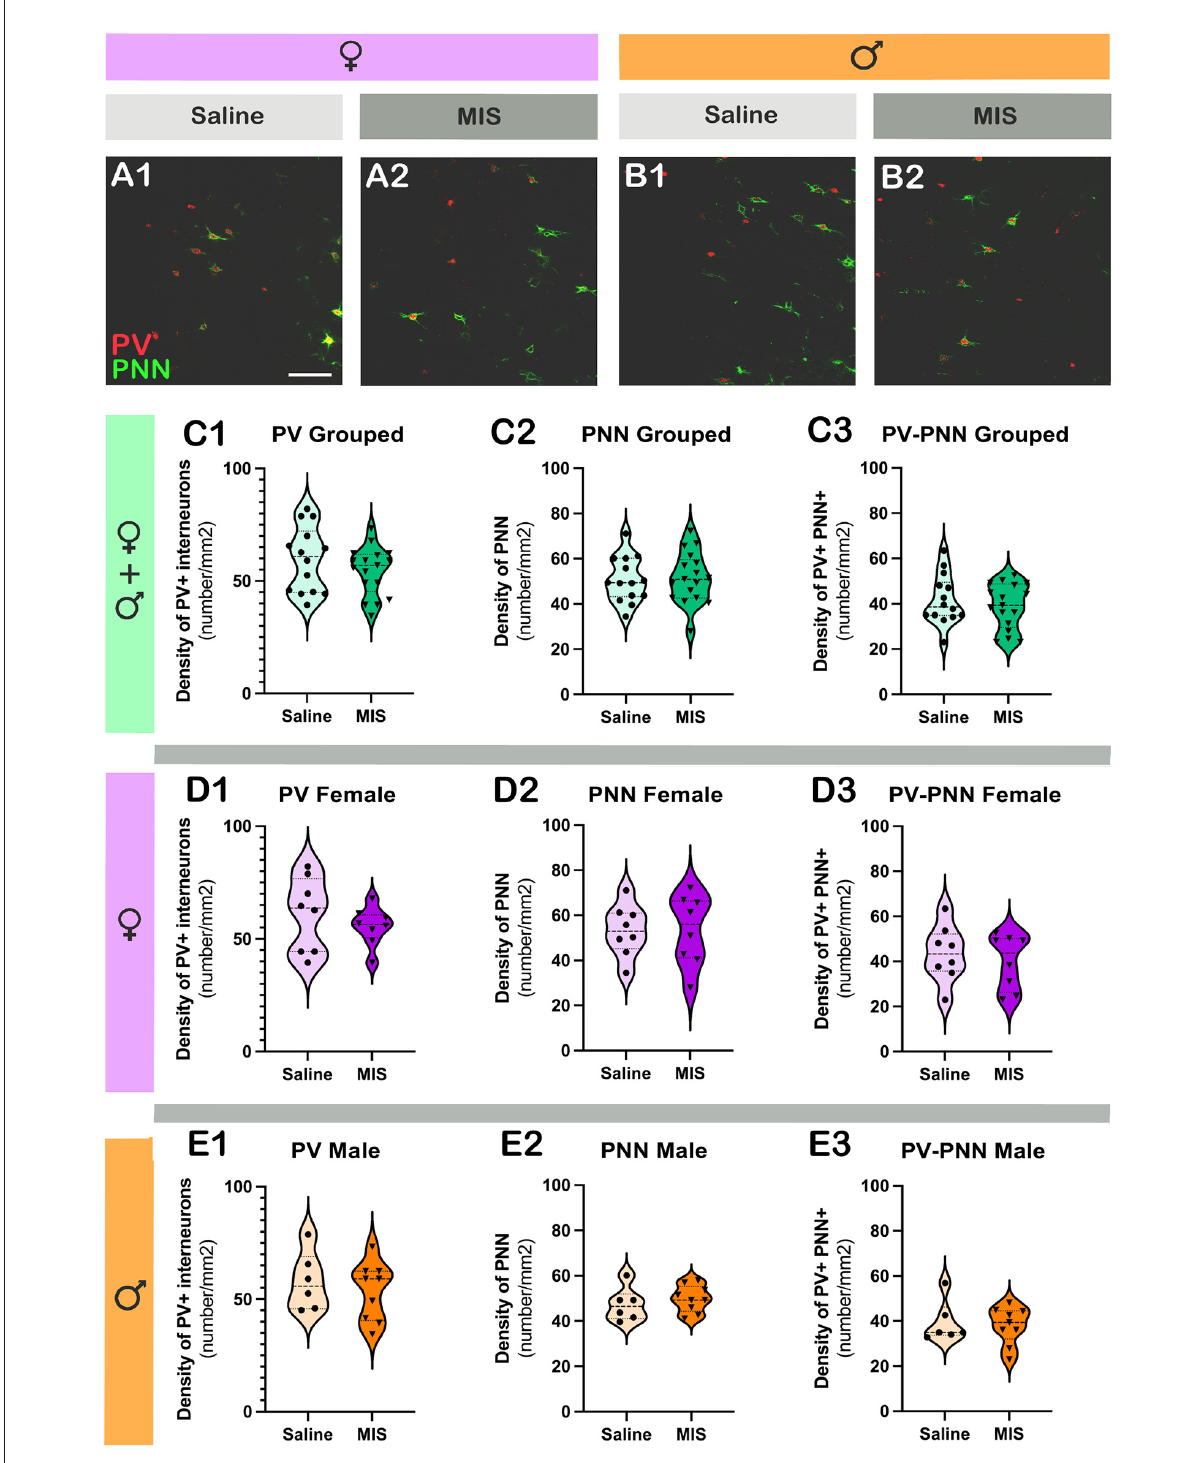
FIGURE4 Analysis of the density of parvalbumin+ interneurons (PV) and perineuronal nets (PNN) in the prelimbic cortex, subregion of the mPFC. (A,B) Representative single confocal planes of parvalbumin+ interneurons (red, PV) and perineuronal nets (green, PNN) of control and MIS treated rats in females (A) and males (B) . (C–E) Graphs representing the effects of poly I:C on the density of PV + interneurons (C1–E1) , PNN (C2–E2) , and PV+ cells surrounded by PNN (C3–E3) . Graphs in the first row (green) include data from all experimental animals (not separated by sex; Saline: n = 14, MIS: n = 17). Graphs in the second row (purple) include data from females (Saline: n = 8, MIS: n = 8). Graphs in the third row (orange) include data from males (Saline: n = 6, MIS: n = 9). Values represent mean ± S.E.M. Scale bar 100 µ